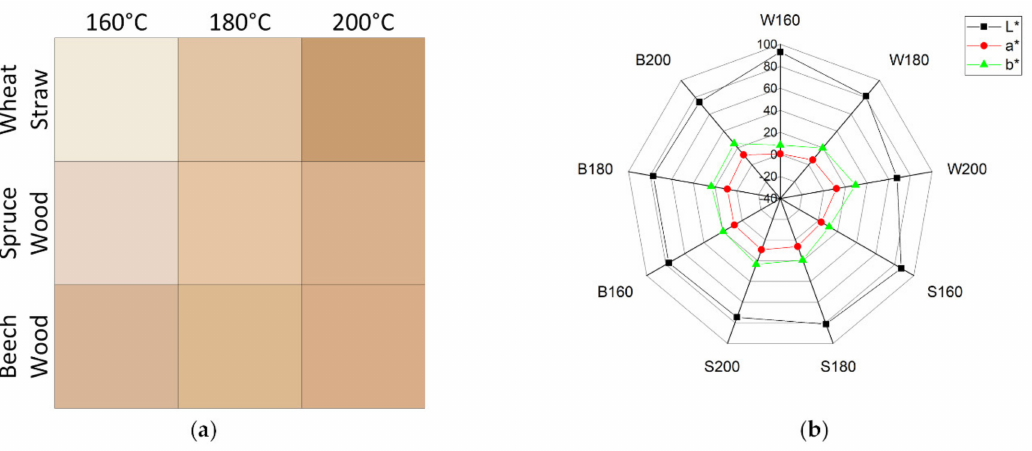
Figure 8. Color of a 3 g/m 2 layer of lignin particles ( a ) and affiliated components in CIELAB-color space ( b